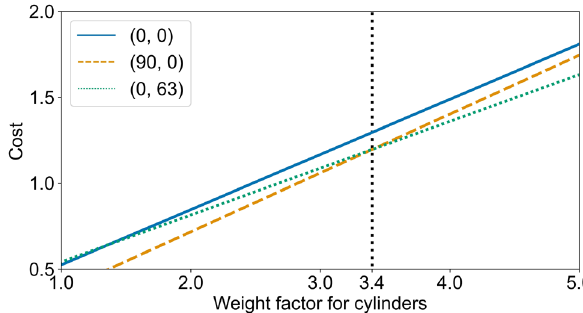
Figure 14: Comparison of three orientations for case part 2 when an additional weight factor is introduced